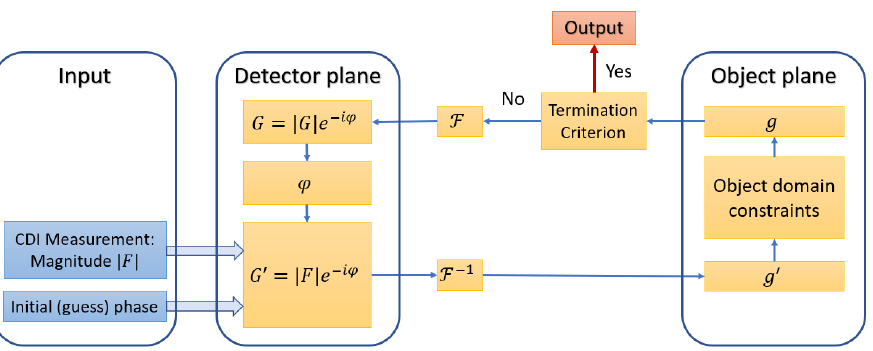
Figure A2. CDI reconstruction algorithm flow